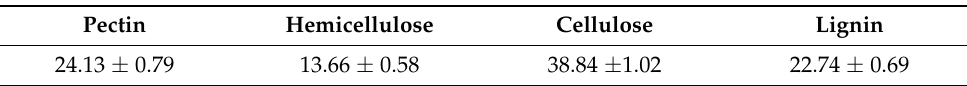
Table 2. Pectin, hemicellulose, cellulose and lignin content in sweet potato dietary fibre (%)